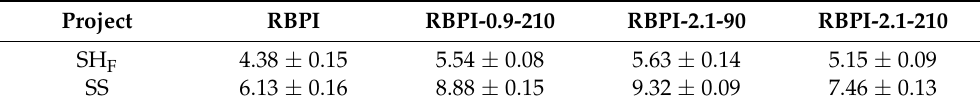
Table 3. Free sulfhydryl and disulfide bond contents (SH F and SS) of RBPI prepared from different SFE pretreatment conditions ( µ